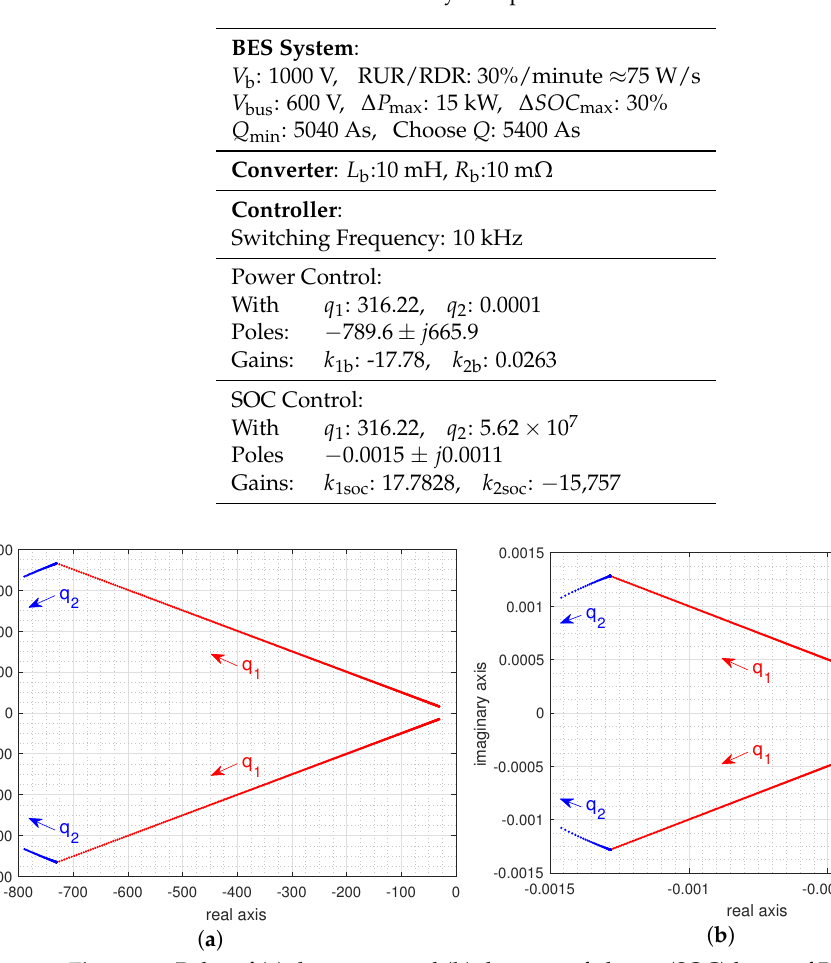
Table 4. BES system parameters.